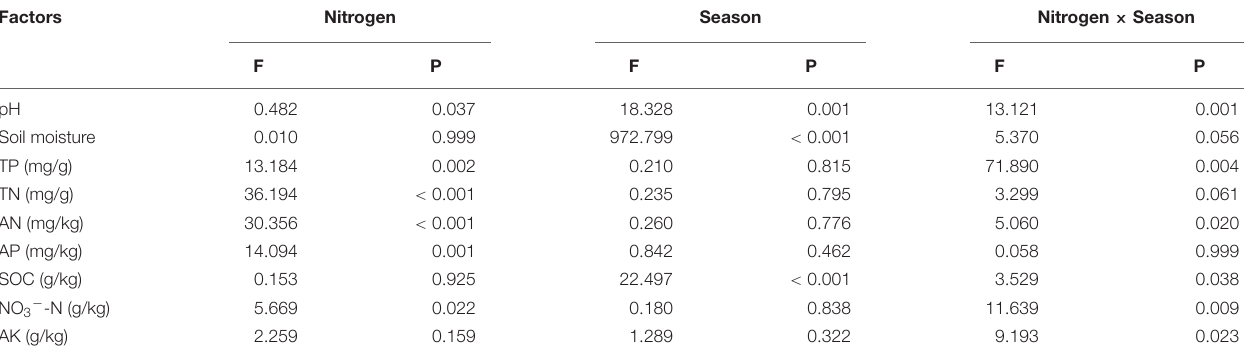
TABLE 1 | Effects of nitrogen addition, seasons, and their interaction on soil variables, as indicated by two-way ANOVA statistics.